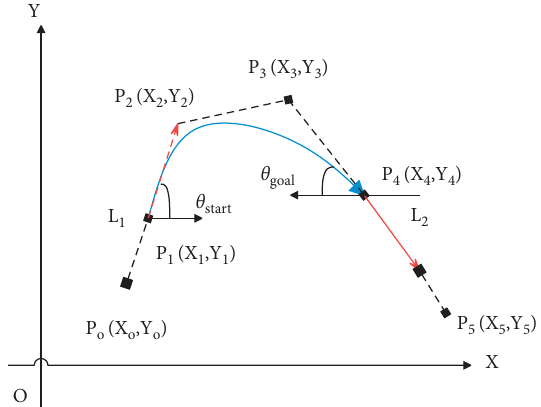
Figure 2: Image of route planning method based on B-spline curve